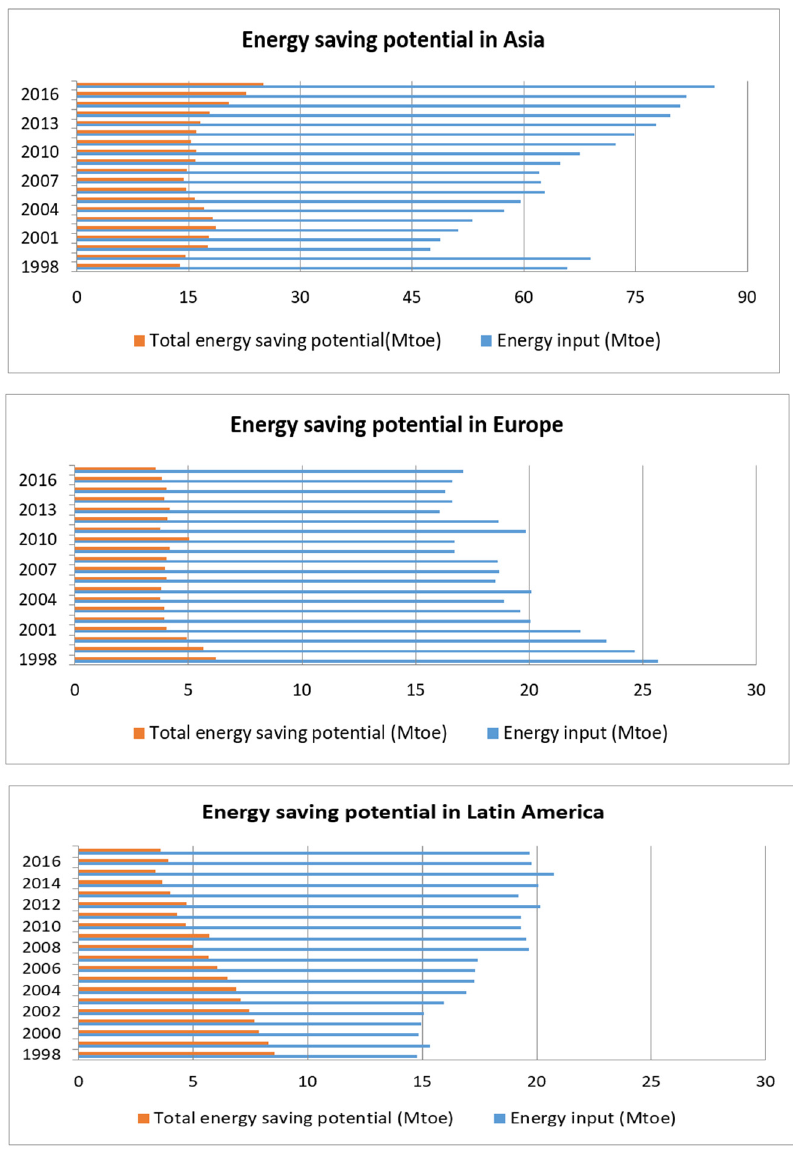
Figure 3. Energy-saving potential in different continents. Data source: energy-saving potential from the estimation according to Equation (8).